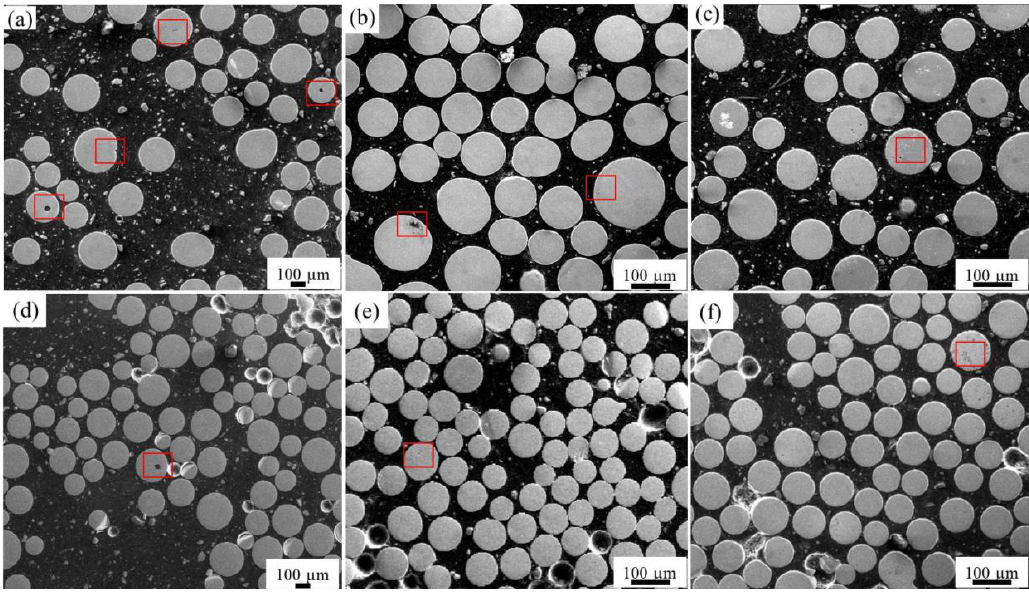
Figure 2. Cross-sectional morphology of ( a ) Ti-6Al-4V, ( b ) Co-Cr-Mo, ( c ) 316-steel at 8000 RPM, ( d ) Ti-6Al-4V, ( e ) Co-Cr-Mo, ( f ) 316-steel at 12,000